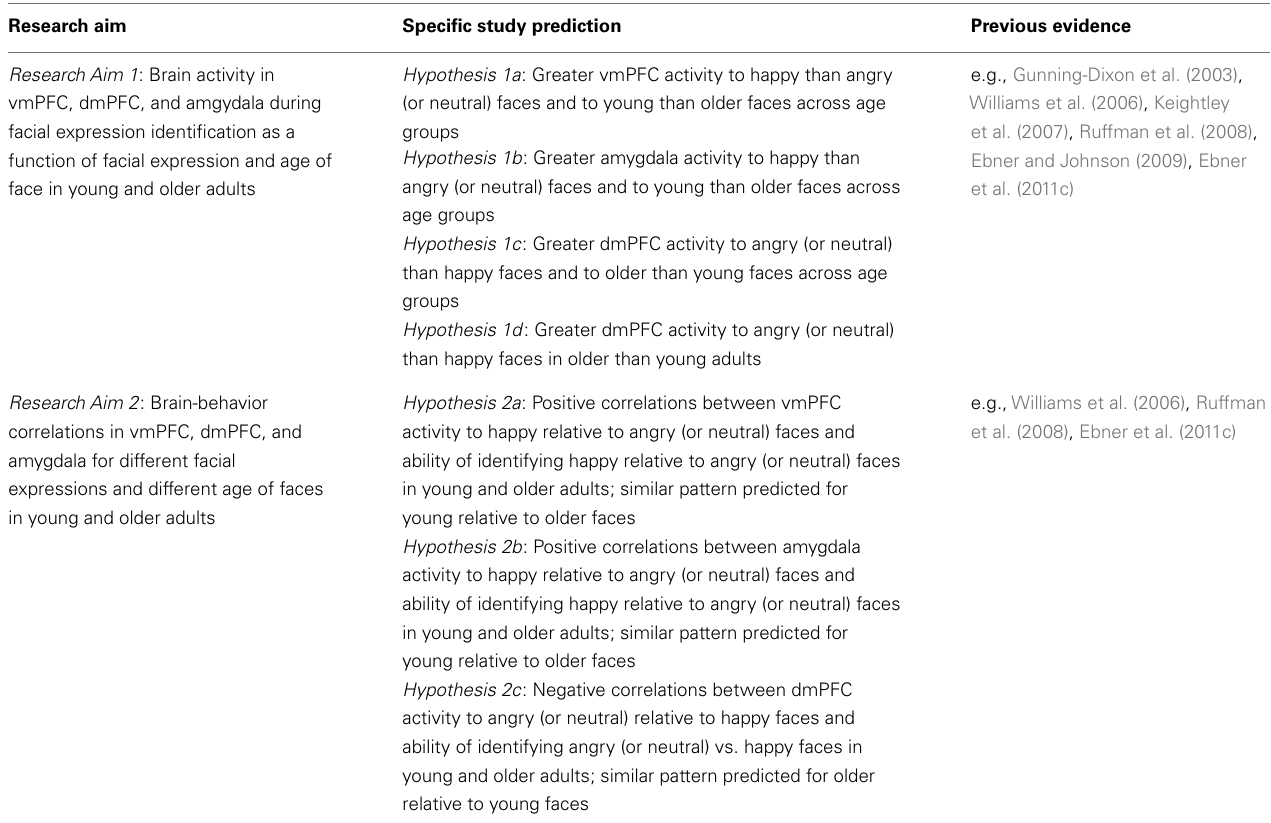
Table 1 | Overview of the central research aims and study